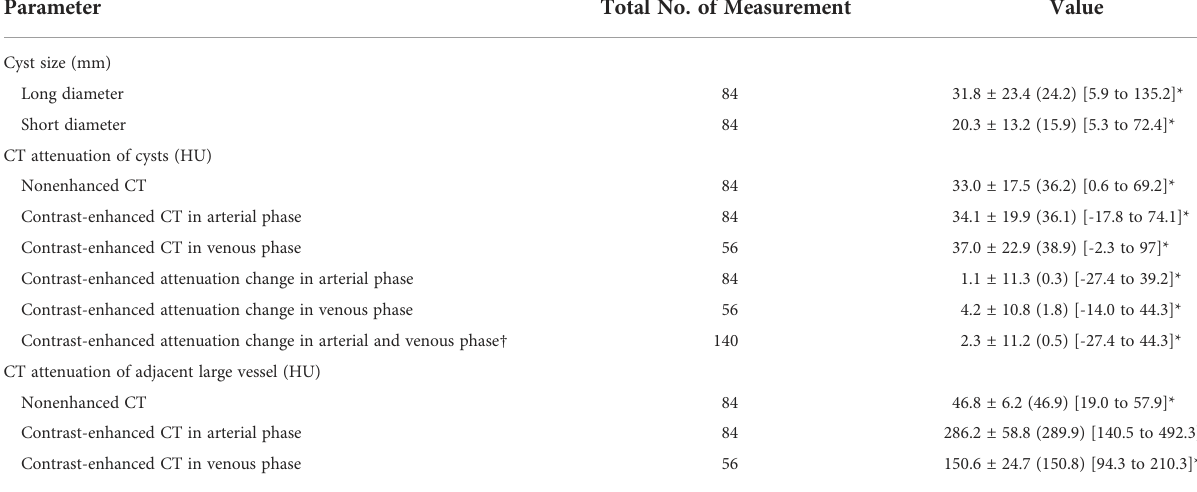
TABLE 1 Cyst size, attenuation of thymic cysts and attenuation of the adjacent large vessel.